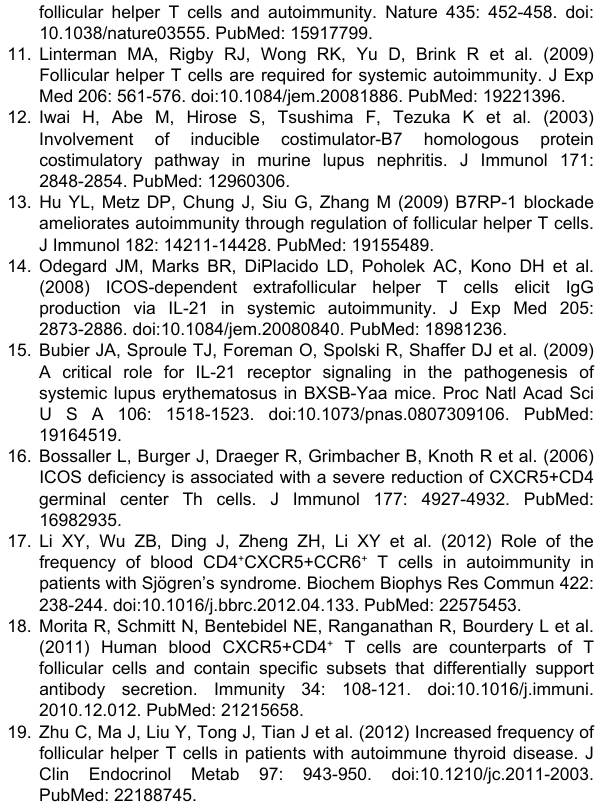
Figure S1. Peripheral CXCR5 - and CXCR5 + CD4 + T cells express similar levels of PD-1 and ICOS. Surface expression of PD-1 and ICOS molecules was analyzed on circulating CXCR5 - and CXCR5 + CD4 + CD45RA - T cells by FACS. Staining with the corresponding isotype control Ab is shown (grey shaded areas)